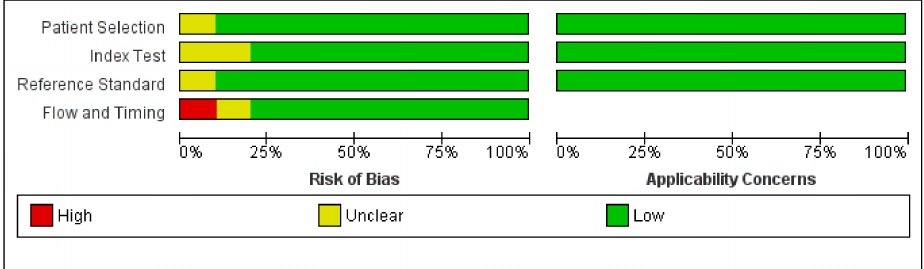
Figure 2. Quality assessment of included studies. Risk of bias and applicability of concerns domains are presented as percentages based on modified Quality Assessment of Diagnostic Accuracy Studies-2 tool. Each bar shows percentage of studies with high (red), unclear (yellow), and low (green) risks of bias and applicability of concerns.